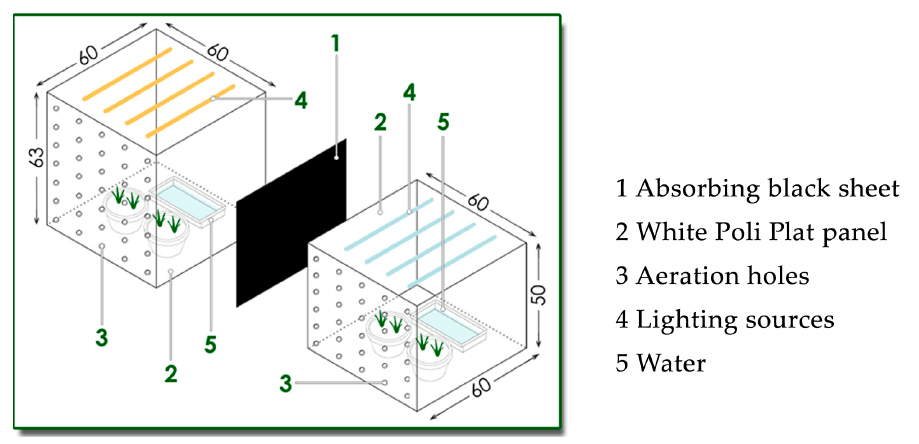
Figure 3. Experimental growth chamber.